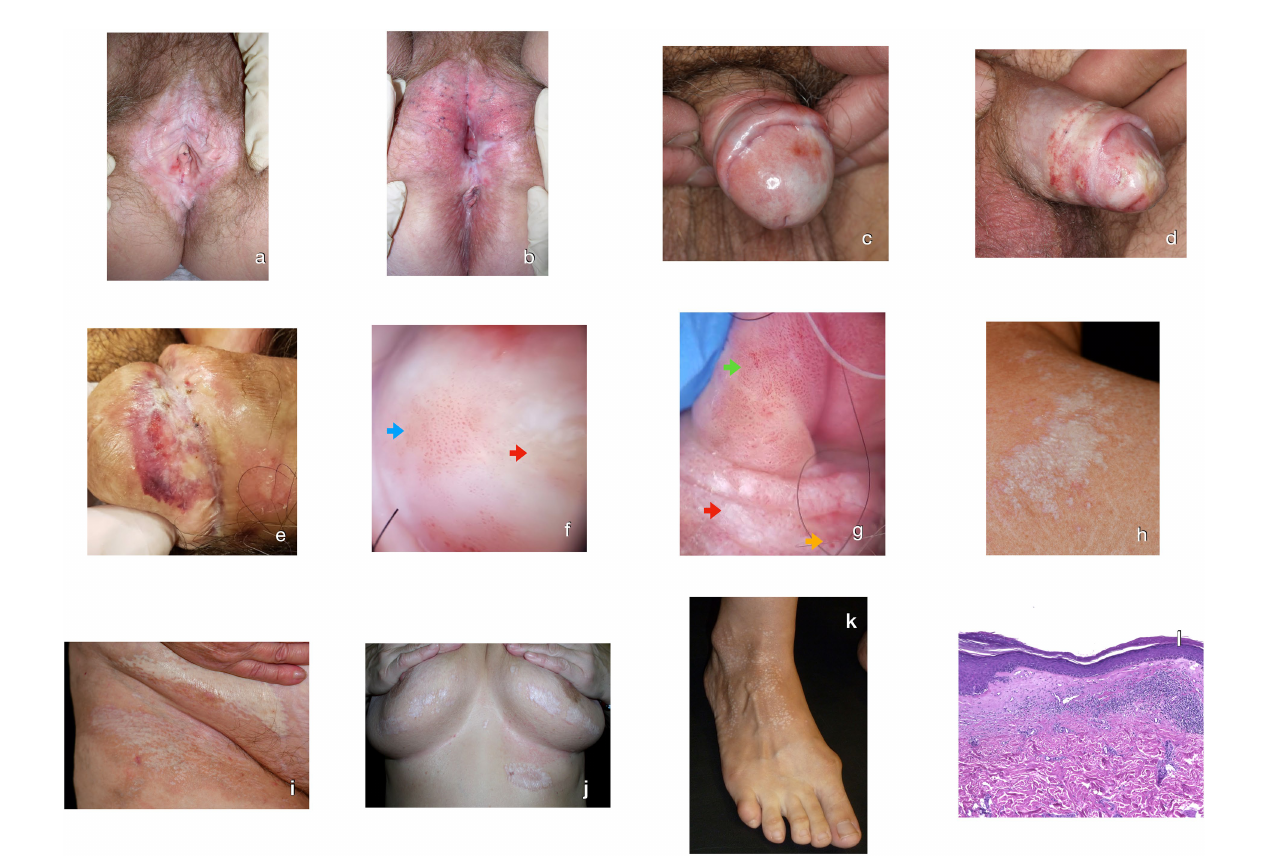
FIGURE 2 Clinical, dermoscopic and histological hallmarks of lichen sclerosus (LS). (A) Ivory-white wax-textured atrophic patches in the vulva. Agglutination, labial resorption, clitoral hood scarring. Fissures and erosions due to the narrowing of the vaginal introitus. (B) Erythema and anogenital scarring. Loss of the normal vulvar architecture with resorption of labia majora and minora. Ivory-white perineal spots perianal and scarring. (C) Hypopigmented macules, erythema and adhesions between glans and preputium. (D) Extensive scarring and atrophy of glans and partial loss of the balanopreputial sulcus. Ecchymotic and hypopigmented penile shaft. (E) Hemorrhagic variant of lichen sclerosus in glans penis over whitish scars, erosions and crusts. (F) Dermoscopy of LS in glans penis with structureless whitish and yellowish patches (red arrow), glomerular and dotted vessels (blue arrow). (G) Dermoscopy of LS in glans penis with penile intraepithelial neoplasia transformation. Glomerular vessels grouped over a pink and yellow surface, compatible with lichen sclerosus (green arrow). Structureless infiltrated whitish areas (red arrow) with glomerular and dotted vessels (yellow arrow), with histopathological confirmation of differentiated penile intraepithelial neoplasia. (H) Scapular ivory-white polygonal coalescing papules with adjacent erythema and comedo-like openings. (I) Whitish extensive macules, surrounded by hyperpigmentation, erythema and areas of ecchymosis on the groin. (J) Mammary and submammary ivory-white wax-textured atrophic coalescing spots with perilesional erythema and hyperpigmentation. (K) Small monomorph ivory-white wax-textured spots in extragenital lichen sclerosus. (L) The histopathology from a skin biopsy showing an atrophic epidermis with compact orthohyperkeratosis, hypergranulosis, degeneration of basal keratinocytes, and exocytosis. Under the thick basement membrane, there is a scarcely cellular zone of sclerosis. In the upper dermis, a superficial lichenoid inflammatory band and vasodilation with perivascular infiltrate are shown (H&E